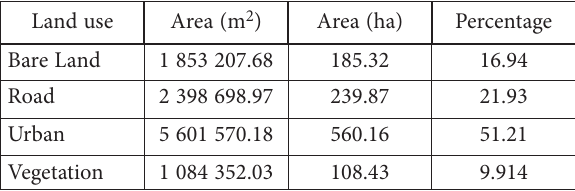
Table 3. Land use area using maximum likelihood classification